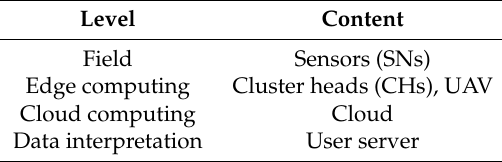
Table 1. Processing